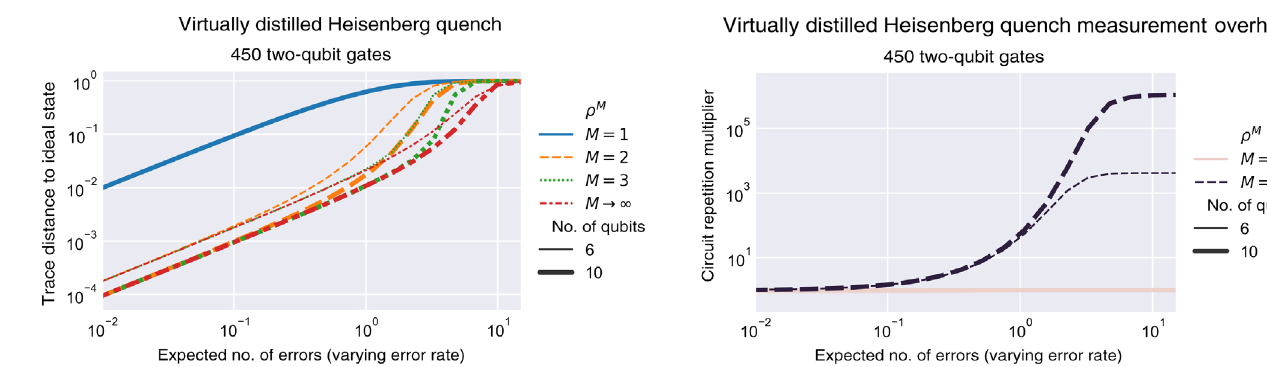
FIG. 9. The average overhead in the number of measurement repetitions required to measure the single-site magnetization (of a Heisenberg model) with virtual distillation ( M ¼ 2 ). The over- head is calculated by taking the ratio of the time required using our technique to achieve a fixed target precision and the time required when measuring the same quantity to the same precision with respect to the unmitigated noisy state ( M ¼ 1 ). We vary the expected number of errors by varying the error rate per gate, fixing the number of two-qubit gates to be 450, and plot the overhead as a function of the expected number of single-qubit depolarizing errors. We show data for six- and ten-qubit systems, denoting the larger system using larger markers. As the error rate grows beyond O ð 1 Þ errors, the overhead increases dramatically, with the larger system seeing the greatest